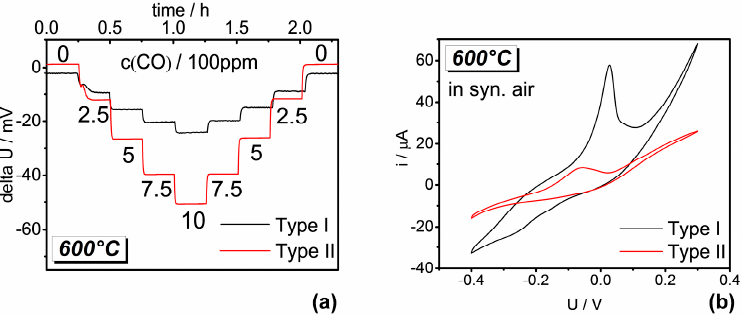
Figure 4. ( a ) Responses of both types of sensors under exposure to CO at different concentrations (conc.) balanced with synthetic air; ( b ) related cyclic voltammograms in synthetic air at 600 °C.